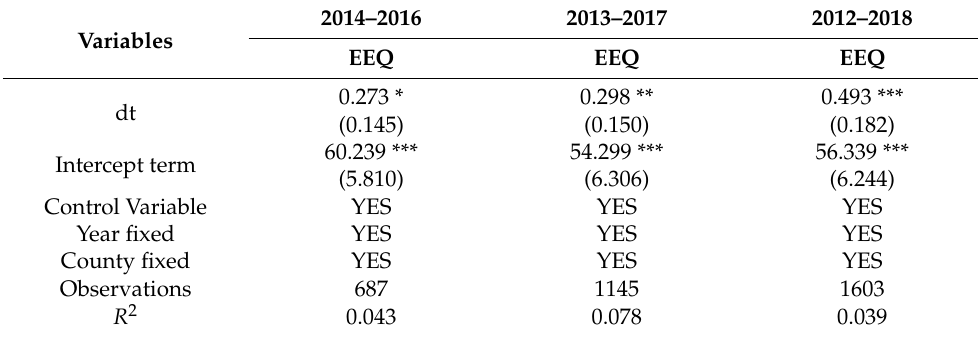
Table 7. Time sensitivity